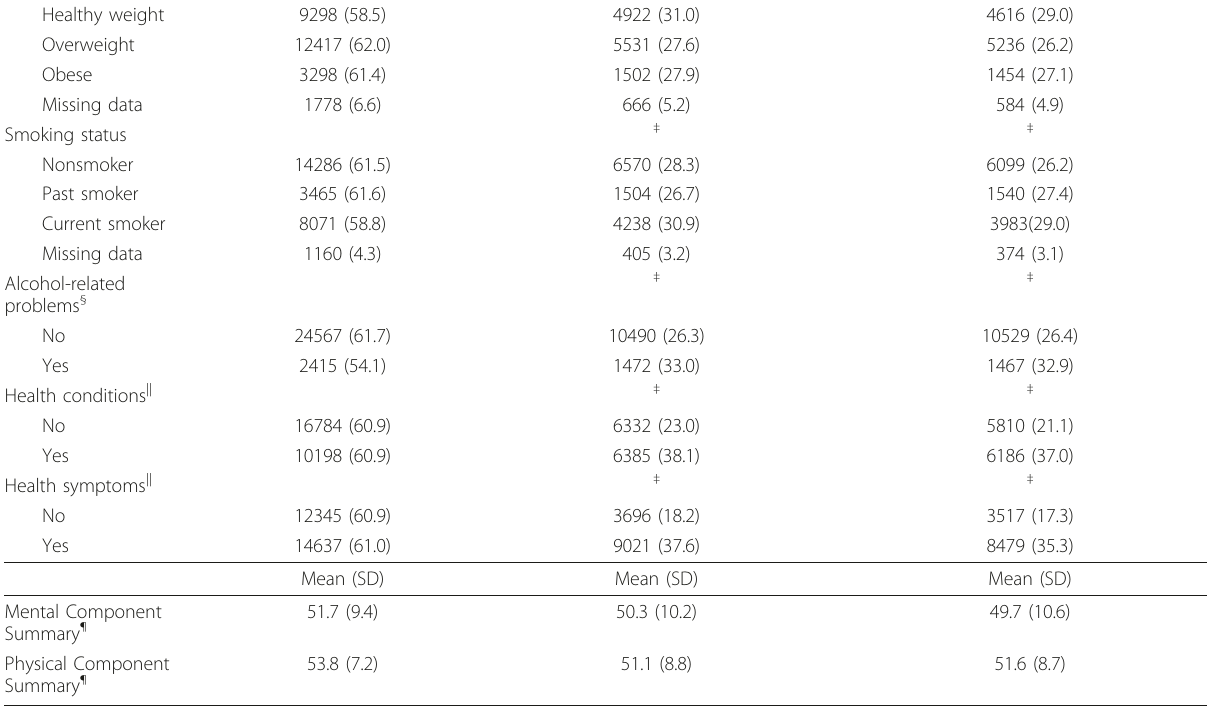
Table 1 Demographic and military characteristics of 2004-2006 active-duty Millennium Cohort participants by comple- mentary and alternative medicine use ( N = 44287)